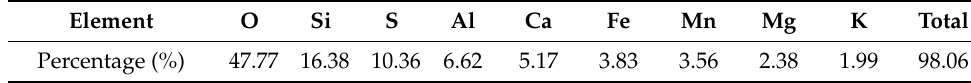
Table 2. Element content of manganese slag.